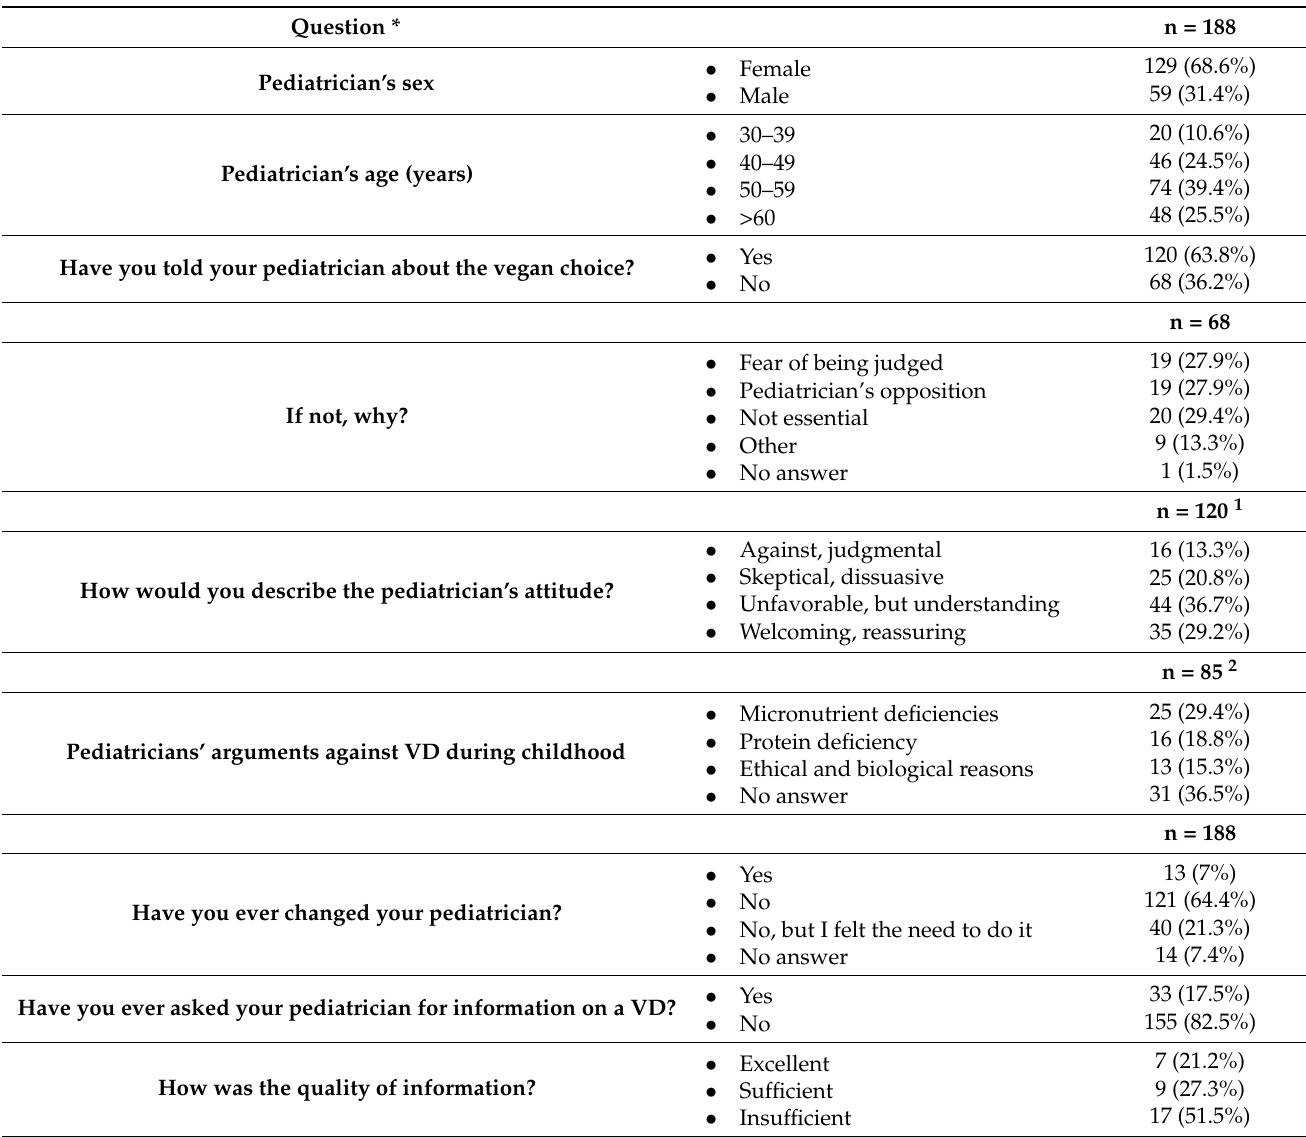
Table 3. Parents’ answers to questions exploring parent-pediatrician relationship regarding a